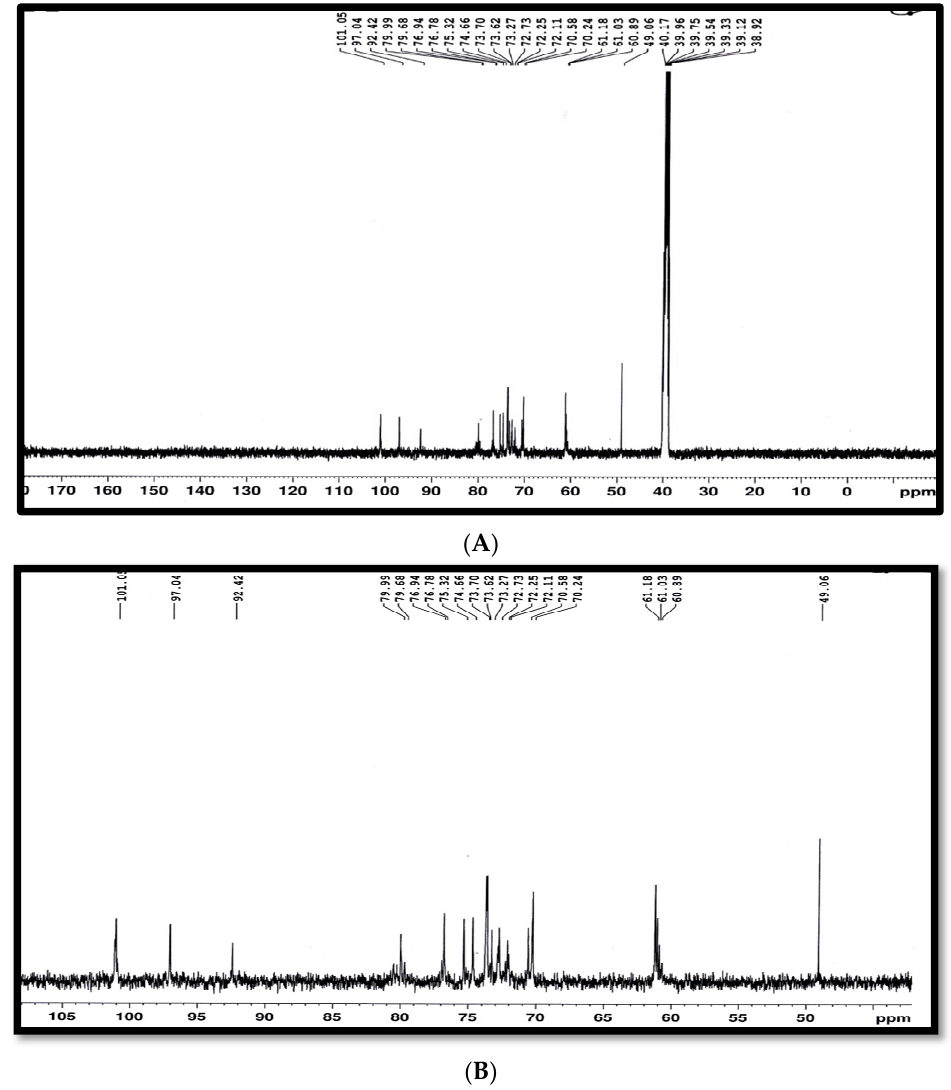
Figure 7. 13 C-NMR spectrum of the antibacterial agent (fraction 6), ( A ) showing full spectrum. ( B ) expansion of 13 C-NMR spectrum partially from 45.00 ppm to 105.00 ppm